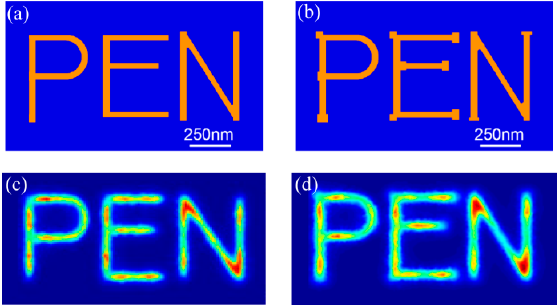
Figure 33. ( a ) Schematic of pattern on mask; ( b ) Optical proximity corrected mask design; Simulation results ( c ) before OPC and ( d ) after OPC. Reproduced from [23], Copyright © 2013, OSA.